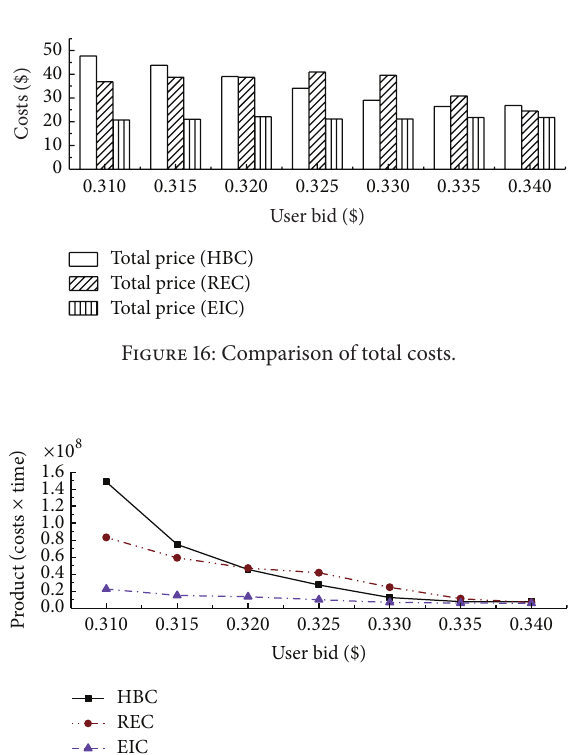
Figure 17: Comparison of combined metrics (total task execution time and